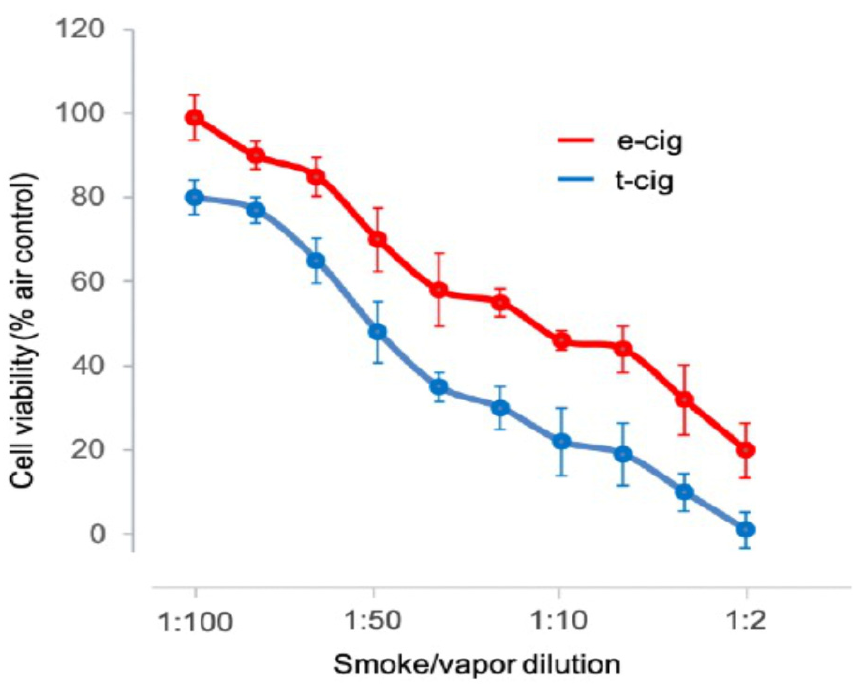
Figure 3. Cell toxicity presented by cellular viability assay (MTT). Human epithelial gingival ker- atinocytes were exposed to several increased dilutions of aerosol and smoke from an e-cig and t-cig compared to fresh air (negative control). Y -axis = OD (optical density), x -axis =